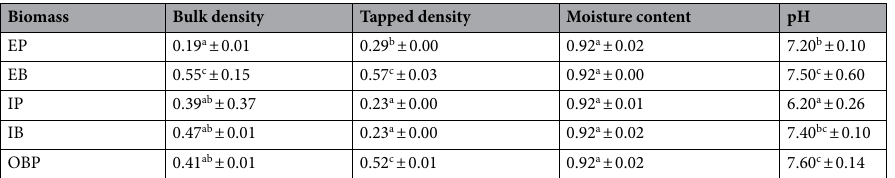
Table 2. Physicochemical properties of lignocellulosic biomass. Means ± standard deviation of triplicate determinations. Means within a column with the same superscript letters are not significantly different (p > 0.05) by Duncan’s multiple range test. EP Ekiti peels of Dioscorea bulbifera, EB Ekiti bulbils of Dioscorea bulbifera, IP Isarun peels of Dioscorea bulbifera, IB Isarun bulbils of Dioscorea bulbifera, OPB Ondo peels and bulbils of Dioscorea